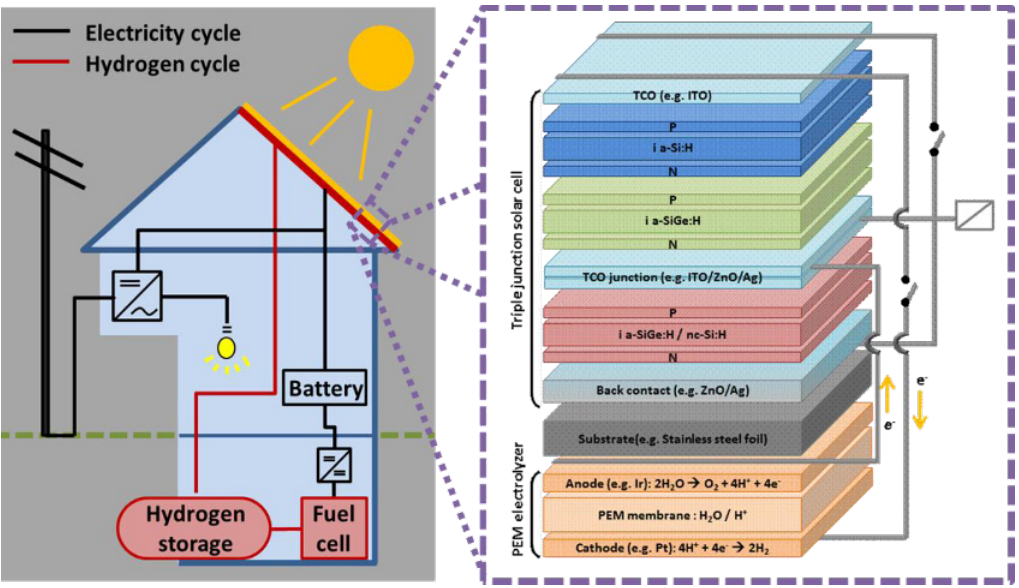
Fig. 2. System scheme of BIPV PV module/PEM electrolyzer system including hydrogen storage and a fuel cell, and electrical inverters (left image). Schematic of the presented concept for the simultaneous generation of solar electricity and hydrogen (right image): The current of the upper dual junction enables the water splitting reaction in the PEM electrolyser directly below the solar cell. Contacts, possible wiring, currents, and water dissociation reaction are shown schematically: The + and − contacts of the upper dual junction cell are directly connected to the PEM electrodes.